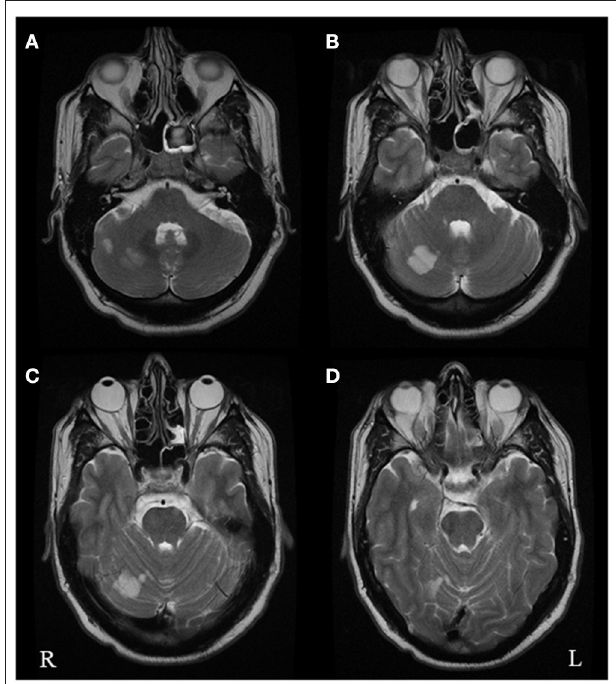
FIGURE 1 | Axial T2 brain MRI images performed in October 2019 following the acute vascular event. The images show multiple foci of restricted diffusion in the right superior cerebellar hemisphere (A–C) within the territory of the right superior cerebellar artery, consistent with acute infarcts. There was no restricted diffusion within the left occipital lobe (D)